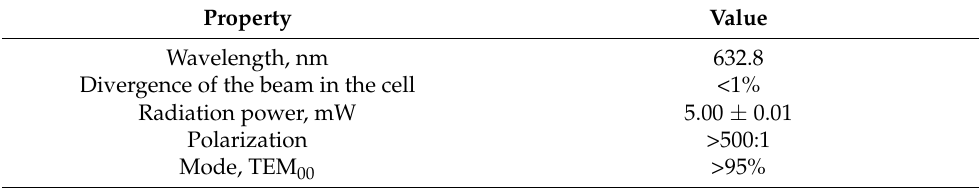
Table 2. Probe laser parameters; laser model HNL050L.